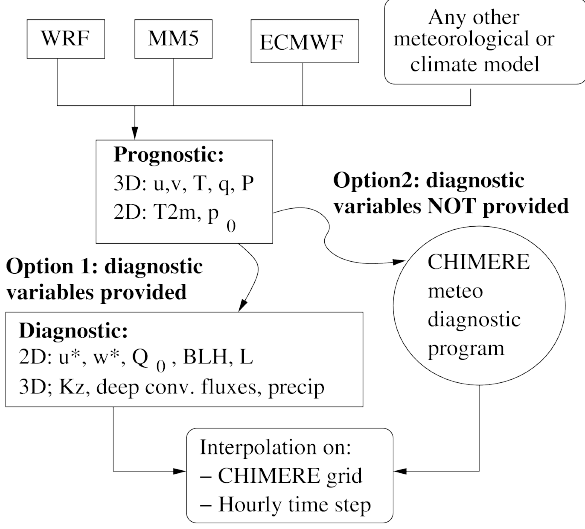
Fig. 7. Treatment of meteorological fields; two options are avail- able: (i) using a meteorological dataset restricted to the mean pa- rameters ( u,v,T,q,P, precipitation) and (ii) using a complete me- teorological dataset that includes turbulent parameters.